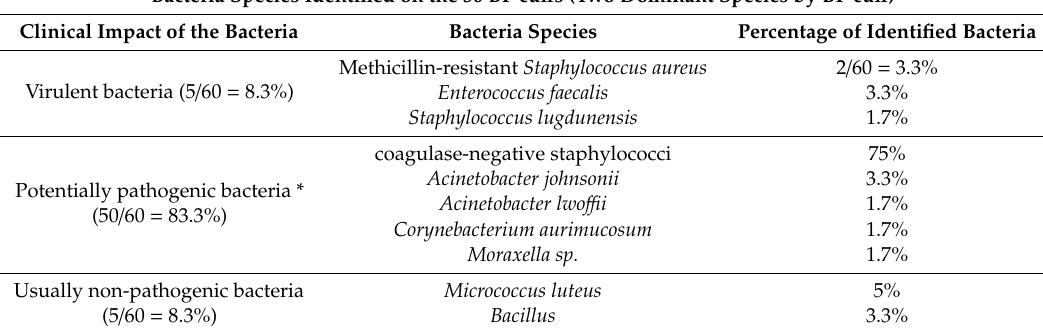
Table 1. Bacteria species identified on the 30 blood pressure (BP) cu ff s (two dominant species by BP cu ff ).